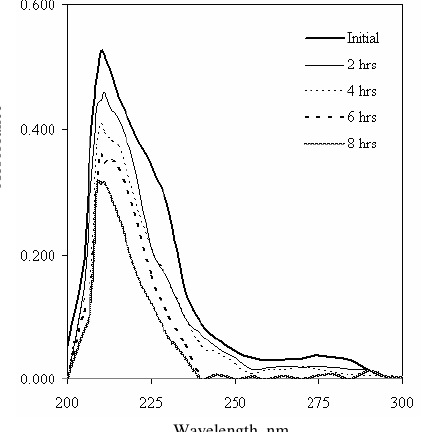
Figure 2a. Spectrum of o -CBA [ o -CBA] = 5.0 x 10-5 M, [2-Naphthol] = 5.0 x 10-5 M, light intensity=11.8 x 10 -8 E sec -1 , pH = 11.5, Temperature = 298 K